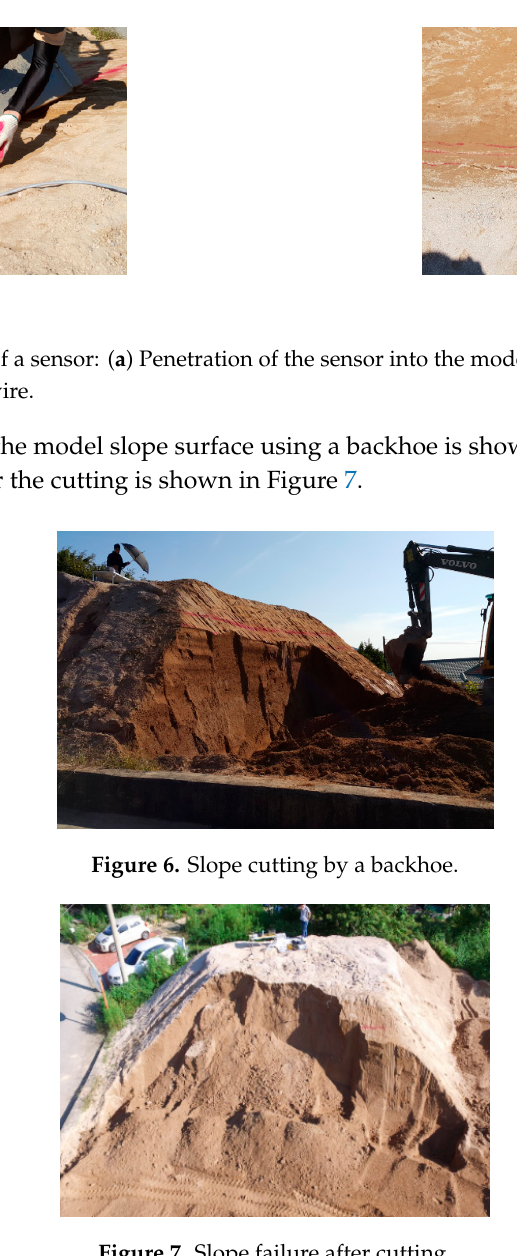
Figure 6. Slope cutting by a backhoe. Figure 7. Slope failure after cutting. Figure 7. Slope failure after